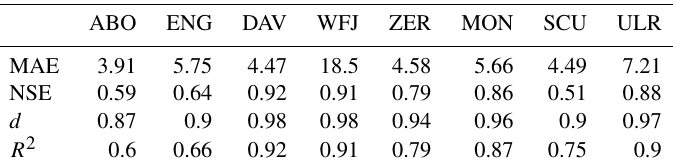
Table 2. Goodness-of-fit measures between measured daily snow depth and SNOWPACK simulated daily snow depth driven by 3-hourly meteorological observations for the period 2000 to 2004. Measures are mean absolute error (MAE), Nash–Sutcliffe coefficiency (NSE), coefficient of determination ( R 2 ) and index of agreement ( d ). See Table 1 for the abbreviations of case studies.